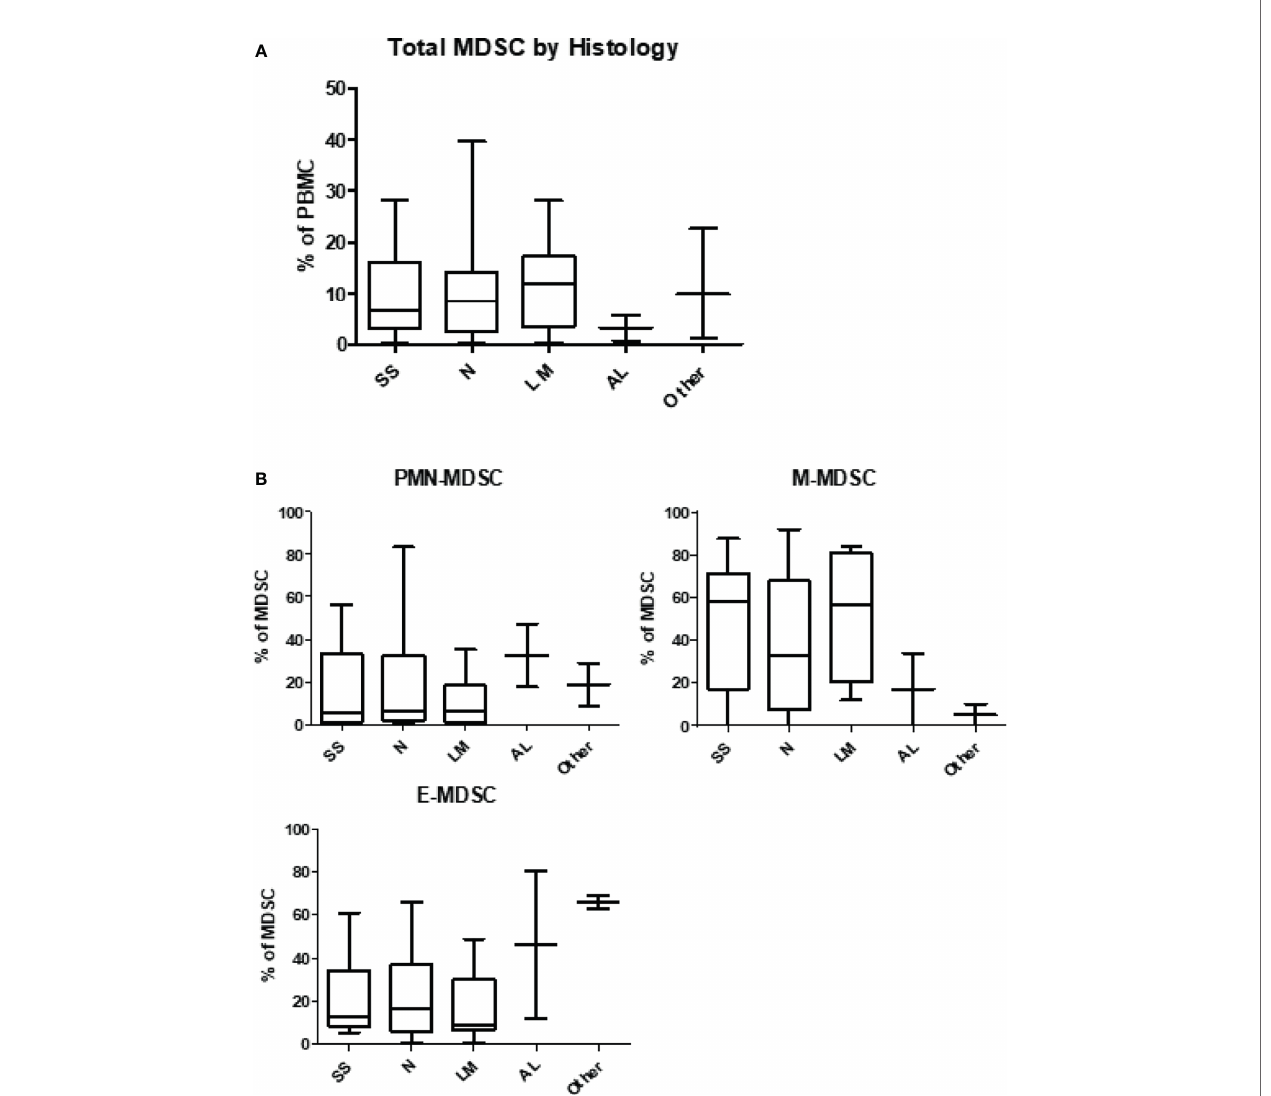
FIGURE 3 | Levels of myeloid-derived suppressor cells according to histologic type of melanoma. Patient PBMCs were isolated from blood draws at the time of initiation of immune checkpoint therapy, and analyzed for MDSC levels and individual subsets. (A) Circulating levels of total MDSC according to histologic type of melanoma. (B) Circulating levels of granulocytic (PMN-MDSC), monocytic (M-MDSC) and early (E-MDSC) MDSC by type of melanoma. SS, Super fi cial Spreading; N, Nodular; LM, Lentigo Maligna; AL, Acral